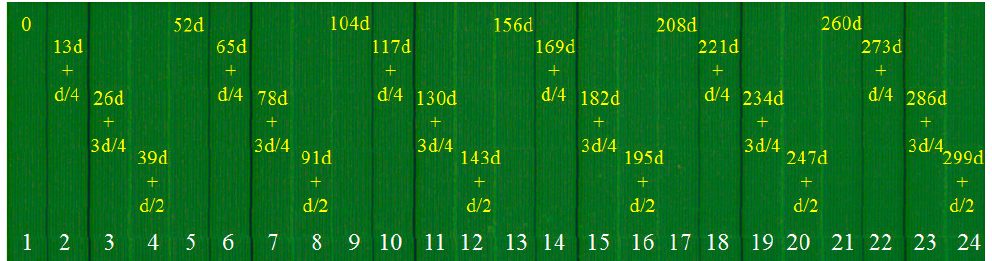
Figure 4. Arrangement of incremental windows of index grating. After modifying the arrangement of the index grating’s incremental windows according to Figure 4, ideally, the phases of the Moiré fringe signals received by the photoelectric device are 0, π /2, 3 π /2, and π , respectively. This arrangement is shown in Figure 5.